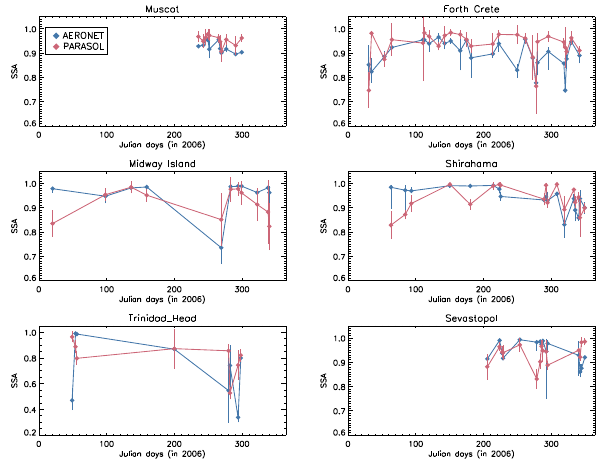
Figure 12. Time series of SSAs (at 670nm) retrieved from the MR PARASOL observations using the goodness-of-fit + cloud screen- ing vs. those retrieved by AERONET for a number of AERONET stations. The error bars for AERONET show the range of all the observations within 12h of the PARASOL overpass and those for PARASOL show the 1 σ retrieval uncertainty. The MR PARASOL retrievals are additionally filtered on the value of the averaging ker- nel of the fine mode imaginary refractive index ( ≥ 0 . 1) in order to ensure adequate sensitivity to the